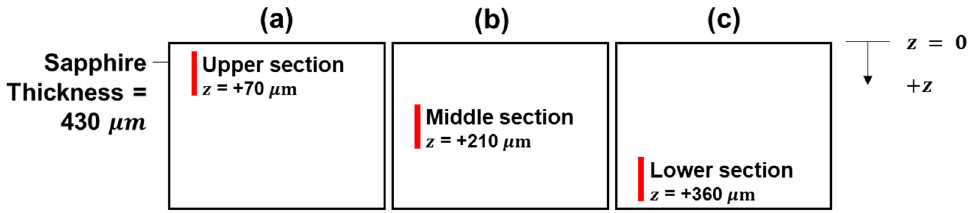
Figure 3. Schematic of the three scanning sections over one-third thickness of the sample with diffractive order 0 positioned at the z values for ( a ) lower (Experiment L27), ( b ) middle (Experiment M27) and ( c ) upper (Experiment U27) sections, respectively.